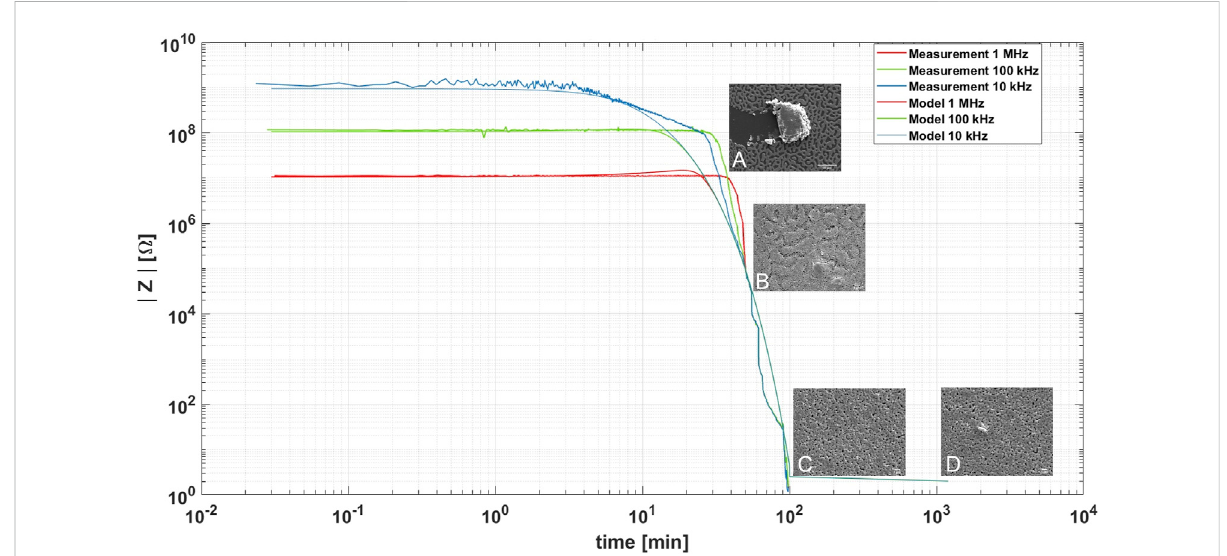
FIGURE 4 Superposition of the analytical model and the measurements made at three different frequencies [10 kHz (Blue), 100 kHz (Green) and 1 MHz (Red)], the capacitive behavior at the beginning of the measurement is observed and after 40 min the system becomes totally resistive. SEM images showing the evolution in the sintering of the ink are observed. (A – D) SEM images show the evolution of ink sintering over